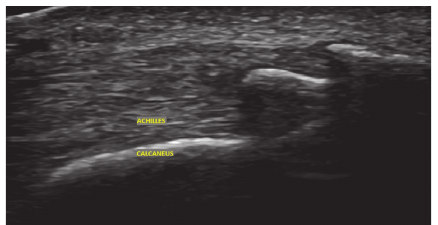
Figure 2: Long axis view ultrasound evaluation in a male with long-time chronic symptoms shows enthesophyte irregularity of the cortex of the calcaneus as well as intratendinous calcification at the Achilles tendon insertion.